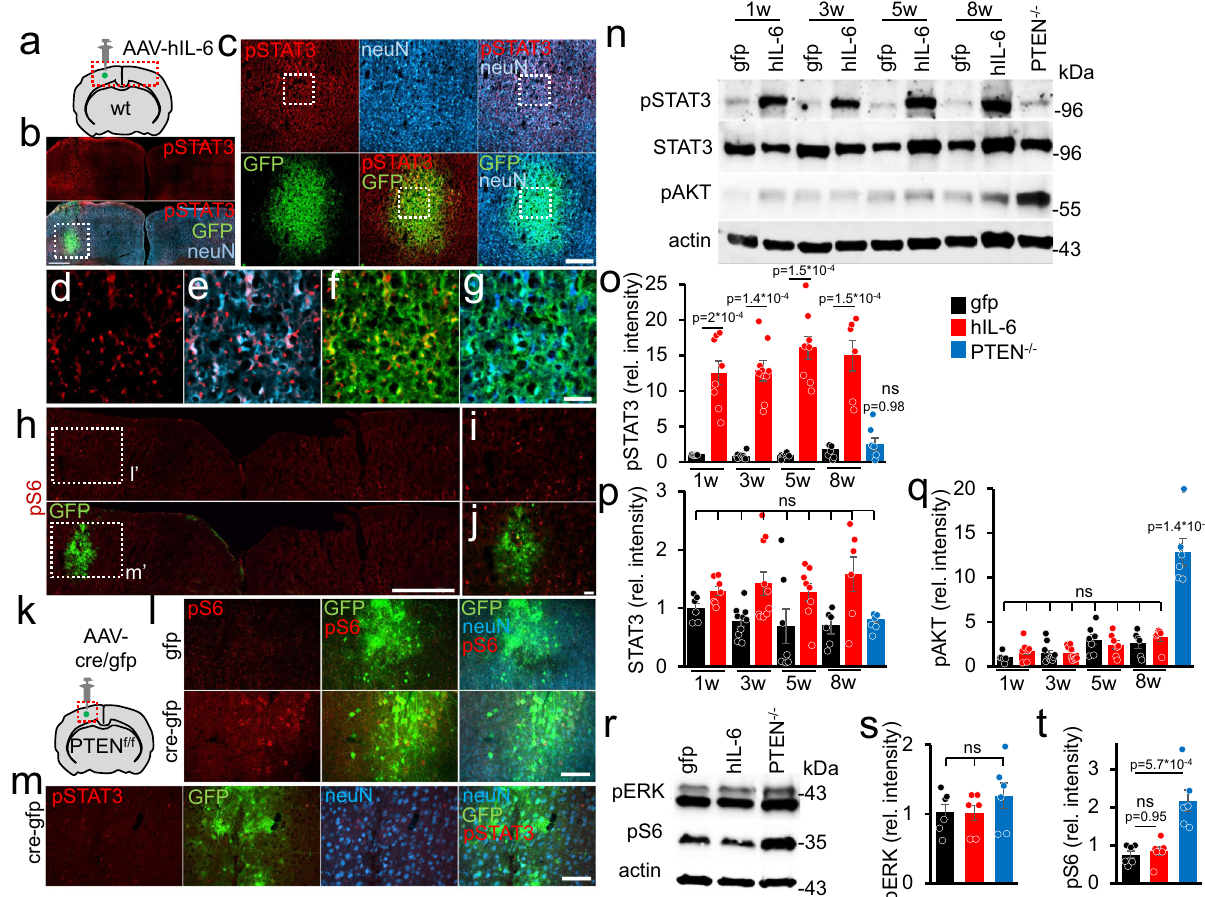
Fig. 1 Activation of signaling pathways by hIL-6 or PTEN − / − . a Schematic drawing illustrating the location of the AAV-injection sites (dashed box) shown in ( b ). b Coronal section of the sensorimotor cortex from a wild-type mouse 3 weeks after intracortical injection of AAV2-hIL-6 into the left hemisphere. The section was immunohistochemically stained for phosphorylated STAT3 (pSTAT3, red) and neuN (blue). GFP (green) was co-expressed by the AAV2- hIL-6. Scale bar: 500 µ m. c Higher magni fi cation of dotted box shown in ( b ). Scale bar: 200 µ m. d – g Higher magni fi cation of dotted boxes in ( c ). Scale bar: 50 µ m. h – j Immunohistochemical staining against phosphorylated ribosomal protein S6 (pS6, red) of sections as described in ( a ). Dashed boxes are presented at higher magni fi cation in ( i , j ). Scale bars: 50 µ m ( i , j ); 500 µ m ( h ). k Schematic drawing illustrating the injection site and location of images shown in ( l , m ). l , m Cortical sections of PTEN f/f mice 3 weeks after AAV2-Cre-GFP (Cre-gfp), or AAV2-GFP (gfp) injections, stained for pS6 ( l , red),